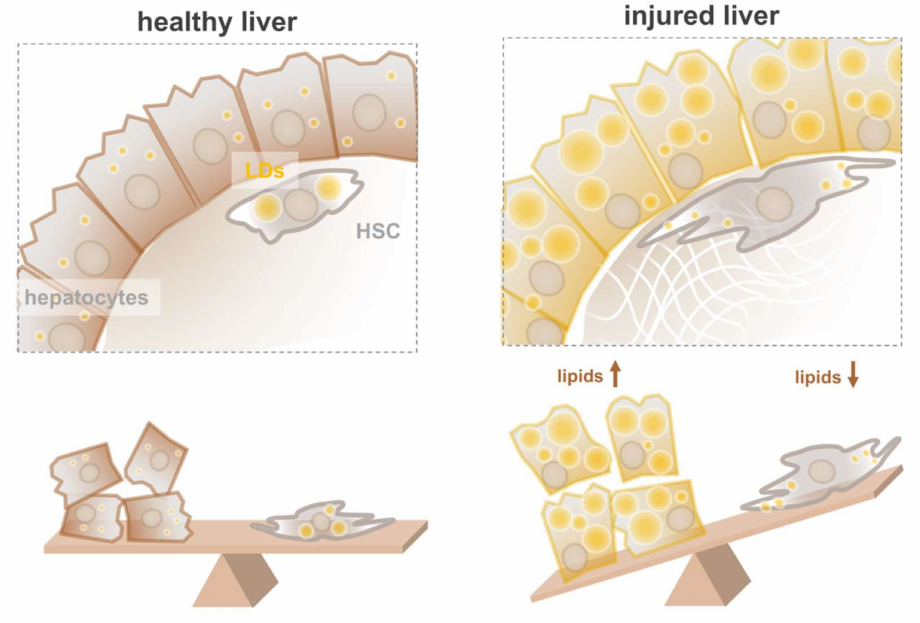
Figure 1. The “fat” paradox in liver. How to specifically target fat accumulation of hepatocytes? Simplified cartoons of ( left ) healthy liver with normal hepatocytes flanked by a quiescent hepatic stellate cell (HSC) with large lipid droplets (LDs), and ( right ) injured liver with lipid-filled hepatocytes flanked by activated HSCs devoid of large